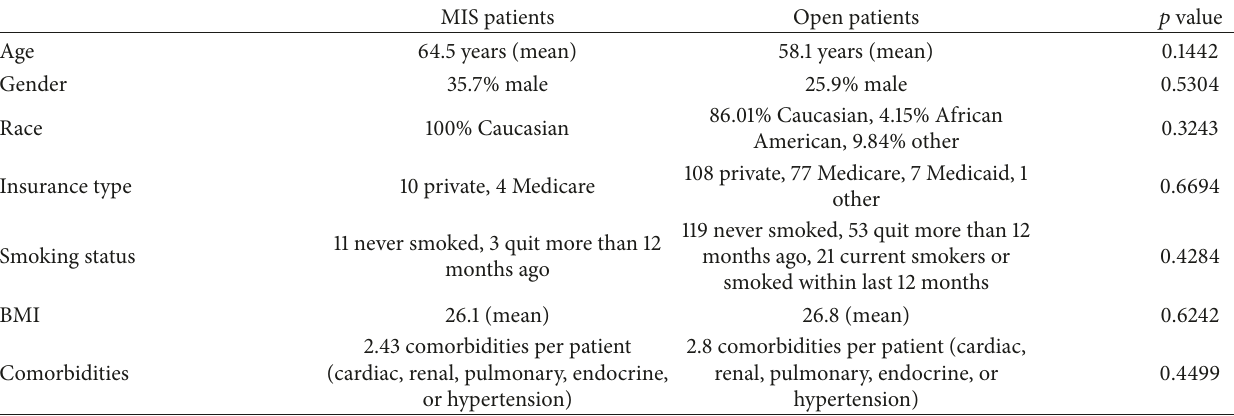
Table 2: Patient demographic data for MIS approach versus open approach.